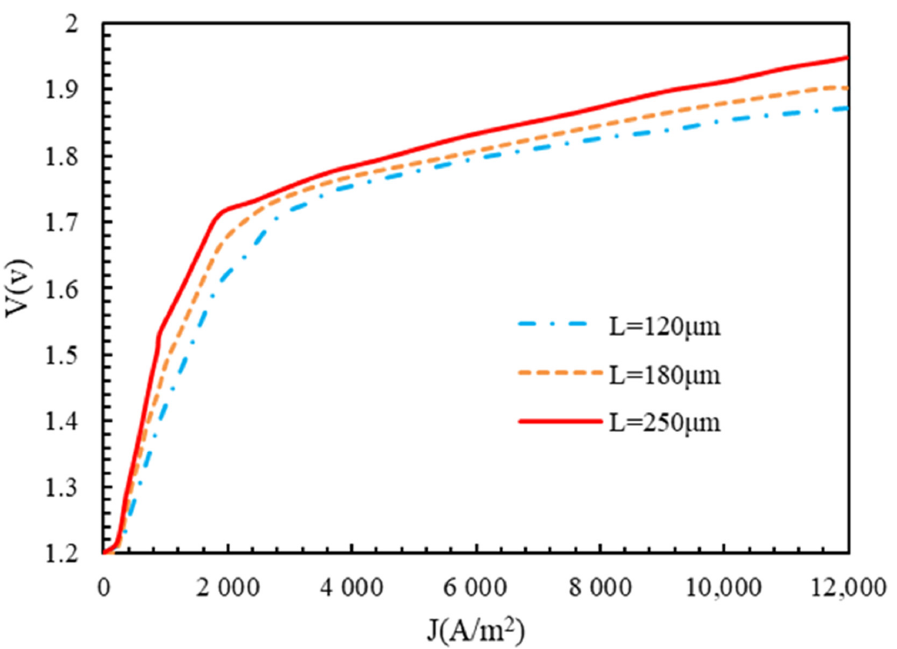
Figure 9. Polarization of polymer membrane electrolyzer for different membrane thicknesses with P = 1 bar, T = 350 K, electrode catalyst of platinum, and membrane of Nafion.